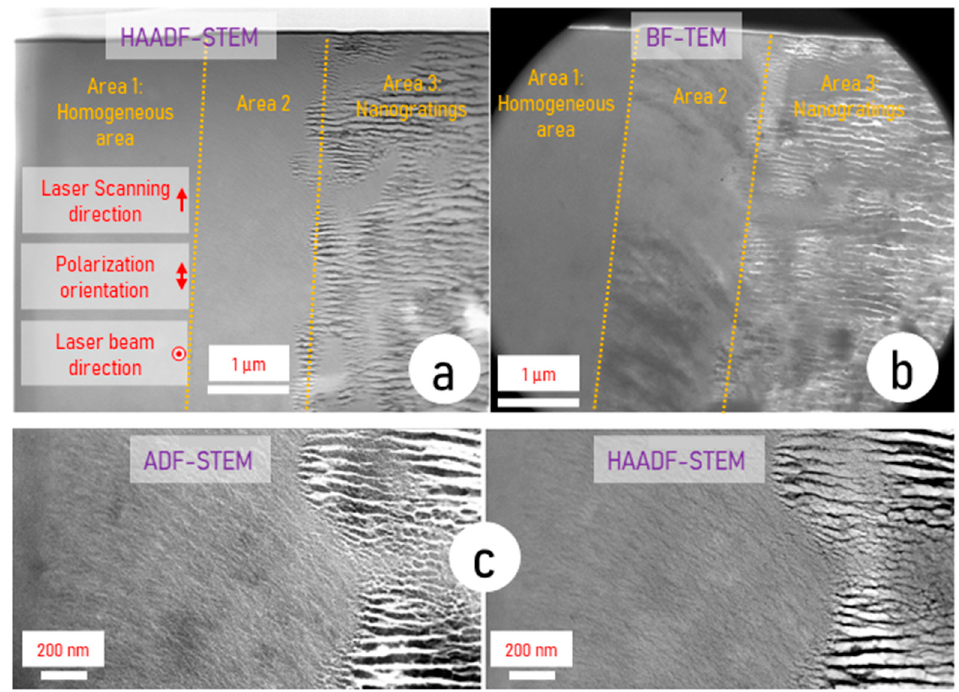
Figure 2. Electron micrographs of LNS sample irradiated by fs laser and investigated using a TITAN3 G2 TEM. ( a ) HAADF-STEM mode, ( b ) BF-TEM mode, and ( c ) magnification on Area 2 using ADF-STEM mode and HAADF-STEM mode.